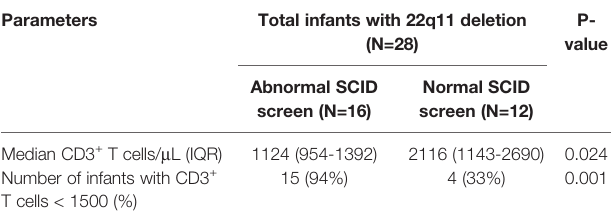
TABLE 3 | Results of newborn SCID screening in infants with 22q11 deletion syndrome diagnosed during the 6-year study period. Parameters